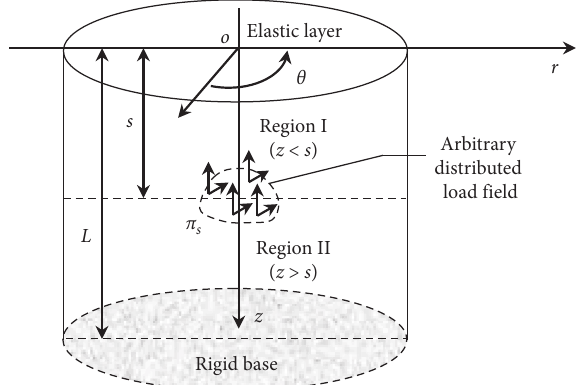
Figure 1: An elastic layer under buried, arbitrary, distributed, and time-harmonic